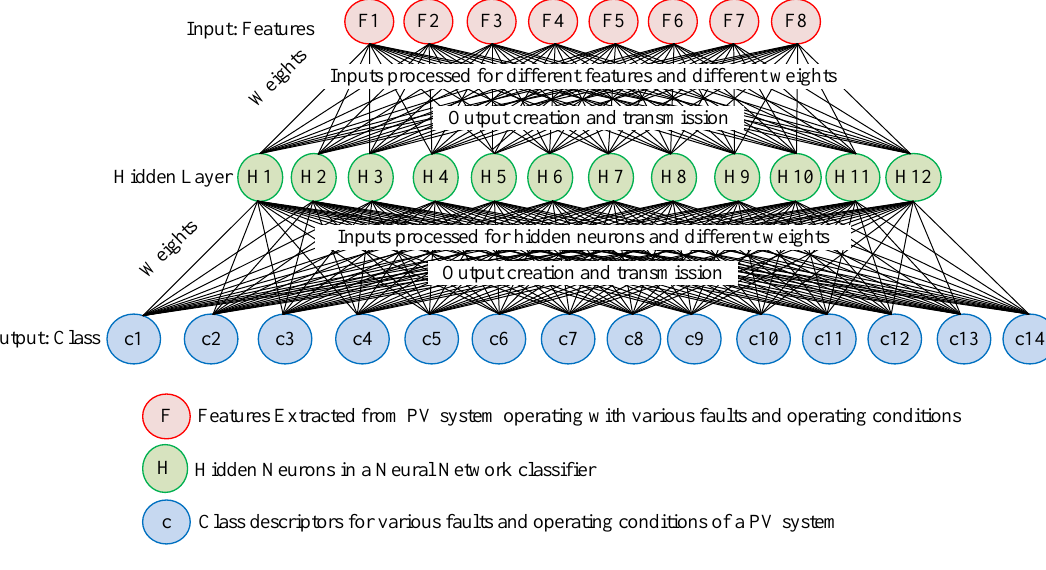
Figure 3. Structure of the Radial Basis Function Neural Network.